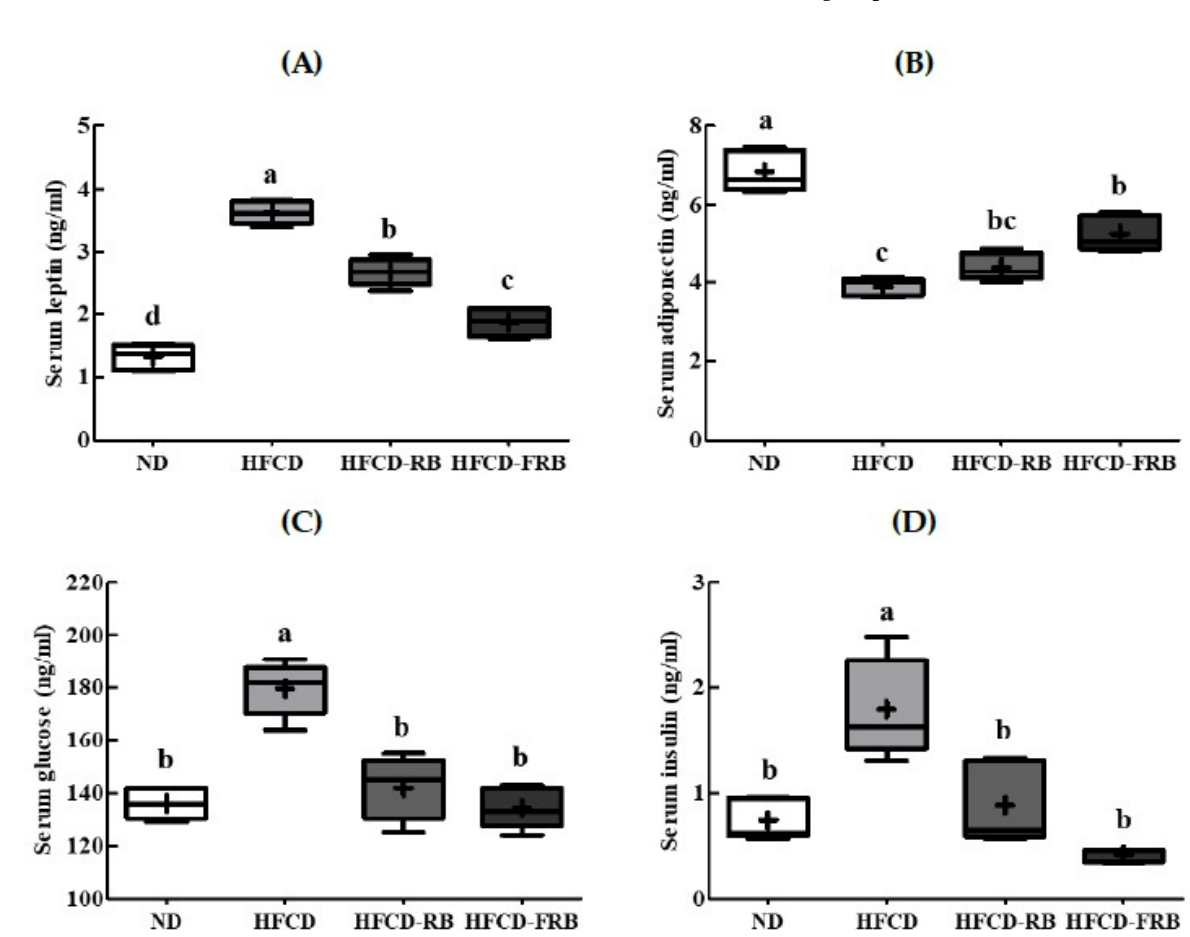
Figure 5. Leptin, adiponectin, fasting glucose, and insulin contents in mice fed experimental diets for 10 weeks. Diet groups: ND, normal diet group; HFCD, high-fat and -cholesterol diet group; HFD-RB, HFCD + non-fermented rice bran powder group; HFCD-FCA, HFCD + fermented rice bran powder group. Serum levels of ( A ) leptin, ( B ) adiponectin, ( C ) fasting glucose, and ( D ) insulin contents were measured in the experimental mice. Values are displayed as a Box-and-Whisker plot with means (expressed as ‘+’), n = 10. a–d: Bars with different letters are significantly different at p < 0.05 by Tukey’s post hoc test.